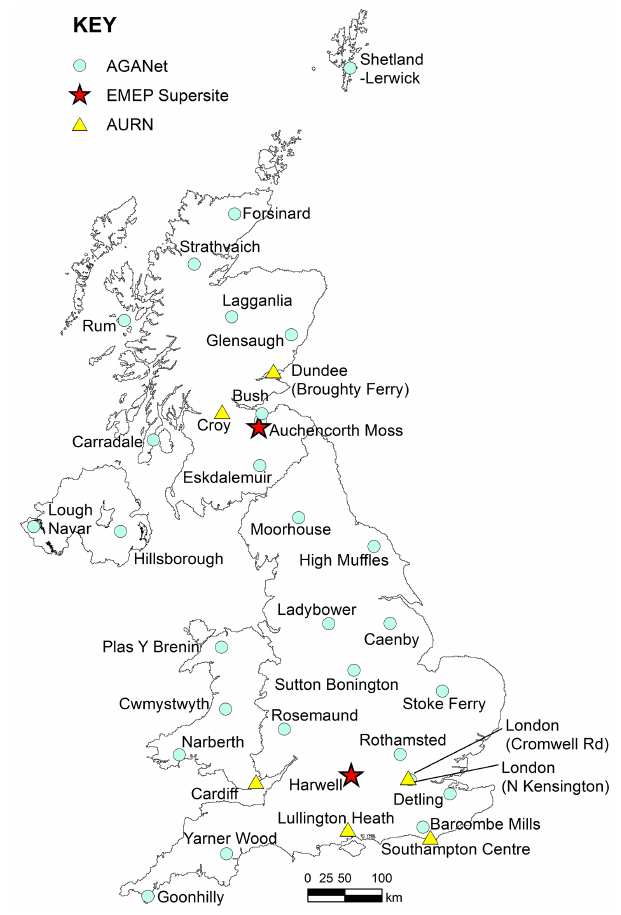
Figure 1. Map of SO 2 monitoring sites in the UK used in this study. The AGANet sites provide monthly average concentrations, whilst the other sites report hourly